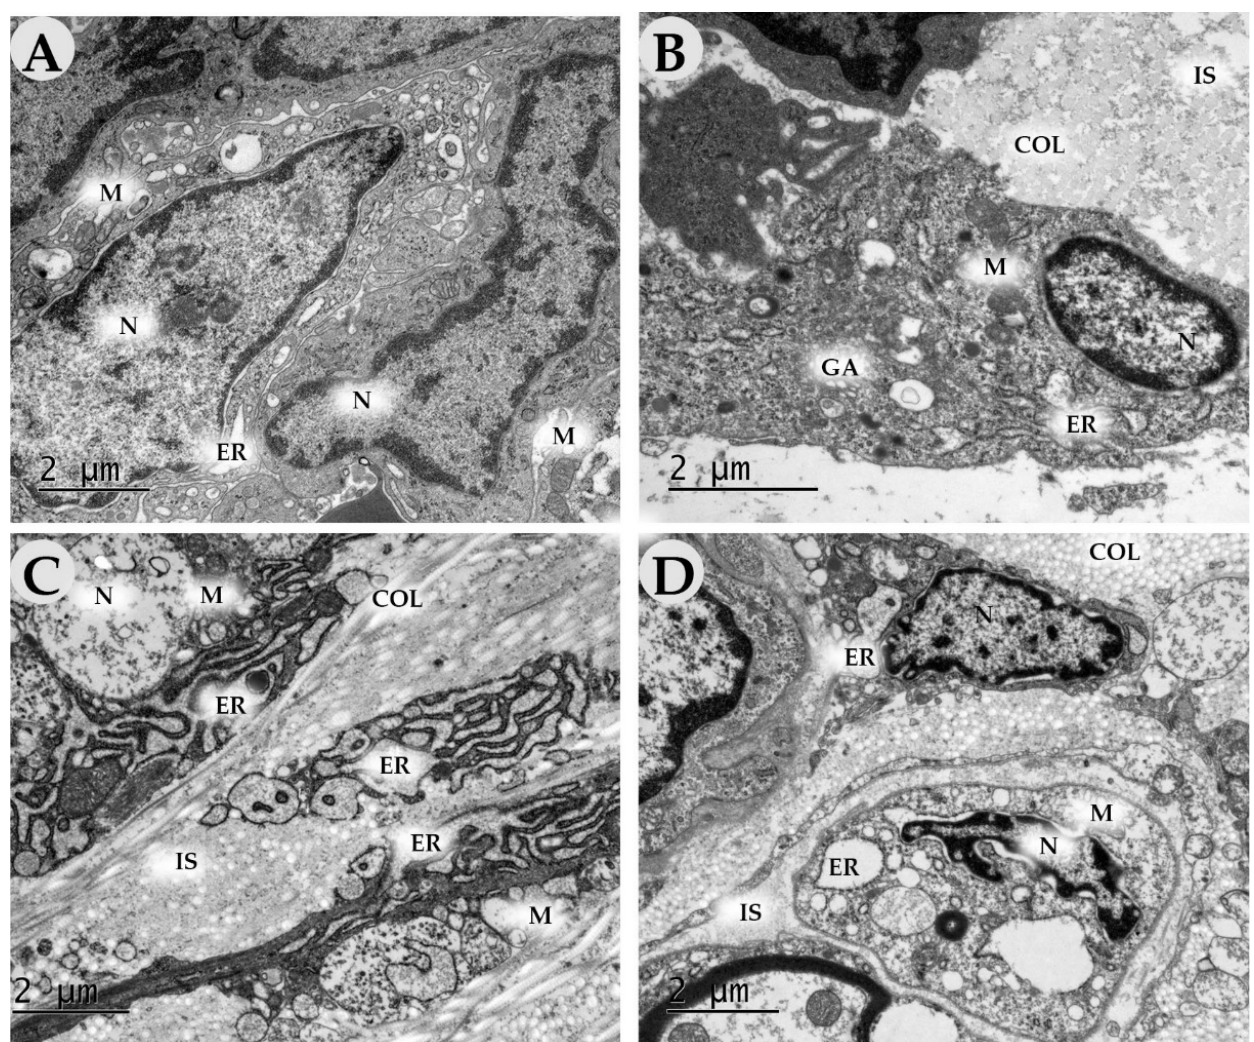
Figure 17. Transmission electron microscopy of the wound bottom of animals in the control (air ( A ), saline ( B )) and experimental groups (NO-CGF ( C ), DNIC ( D )) on day 7. Magnification × 15,000. N—nucleus, M—mitochondria, GA—Golgi apparatus, ER—endoplasmic reticulum, IS—intermediate substance, COL—collagen.